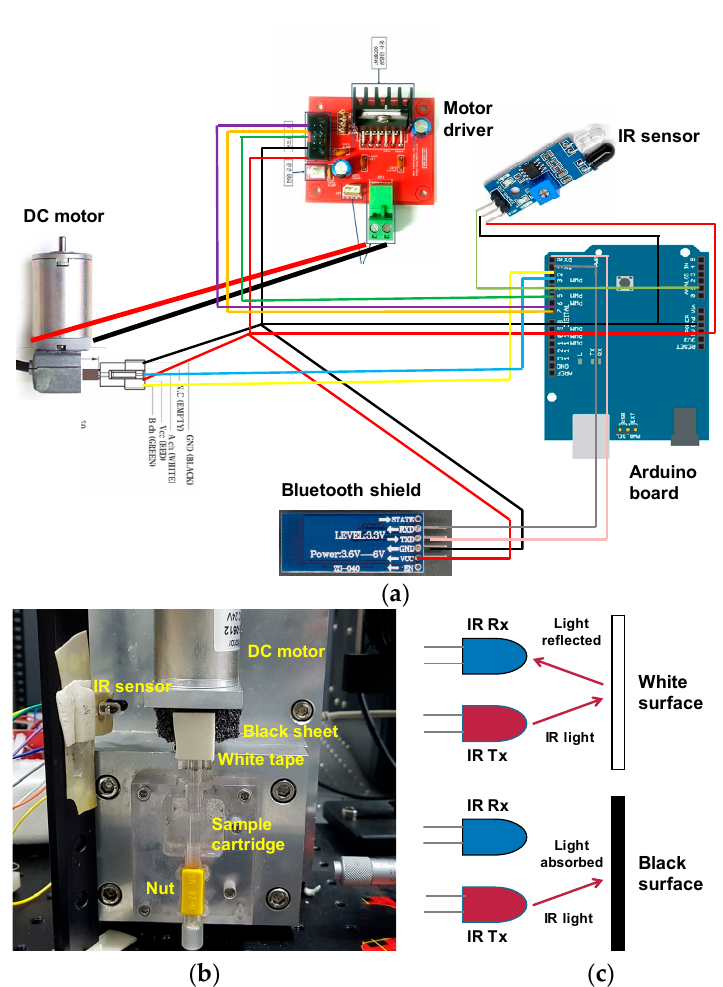
Figure 2. ( a ) Motor system comprising an Arduino board and a DC motor controlled wirelessly by a smartphone. ( b ) Photograph of the experimental setup for motor control system. ( c ) Schematic diagram of the working principle of the infrared (IR) sensor.